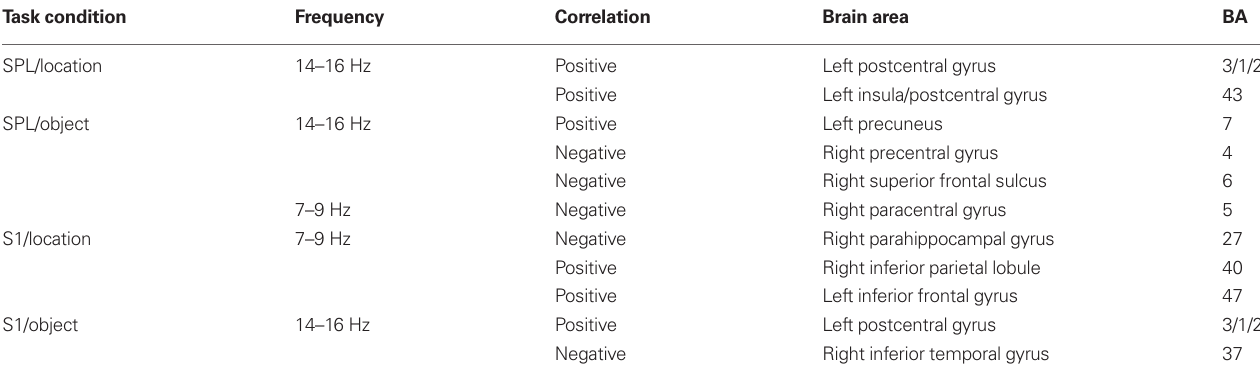
Table 1 | Cortical sources of correlations between rTMS-induced change in oscillatory power and rTMS-induced change in RT. For each task condition, correlations were calculated by determining the mean change in power over the time and frequency ranges indicated by the dotted rectangles in Figure 6 . Task